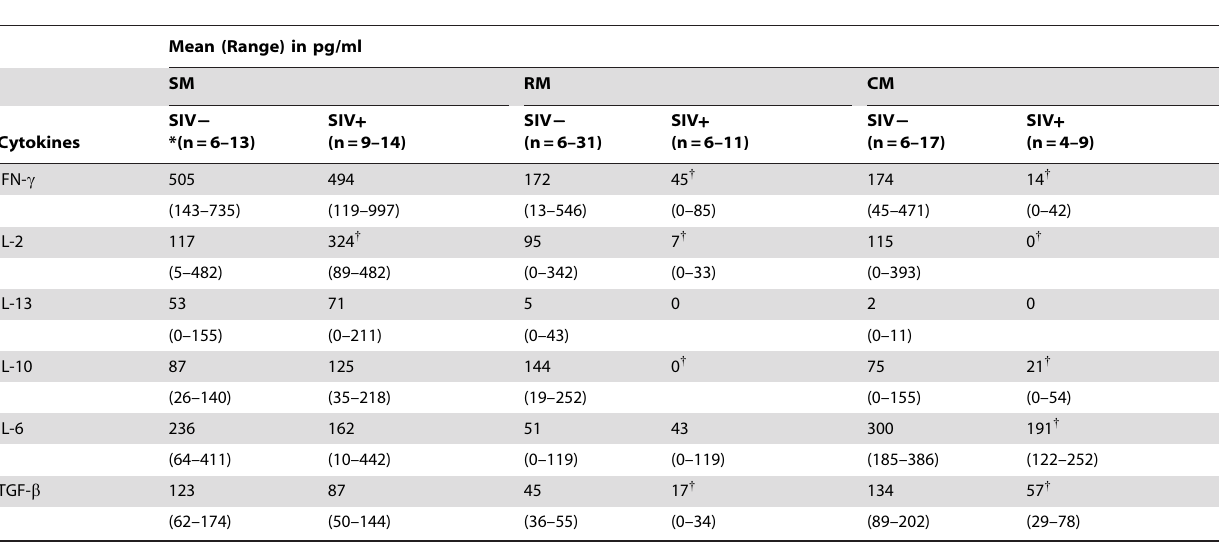
Table 2. Comparison of ex vivo NKT function in SIV-negative and SIV-infected sooty mangabeys (SM), rhesus macaques (RM) and cynomolgus macaques